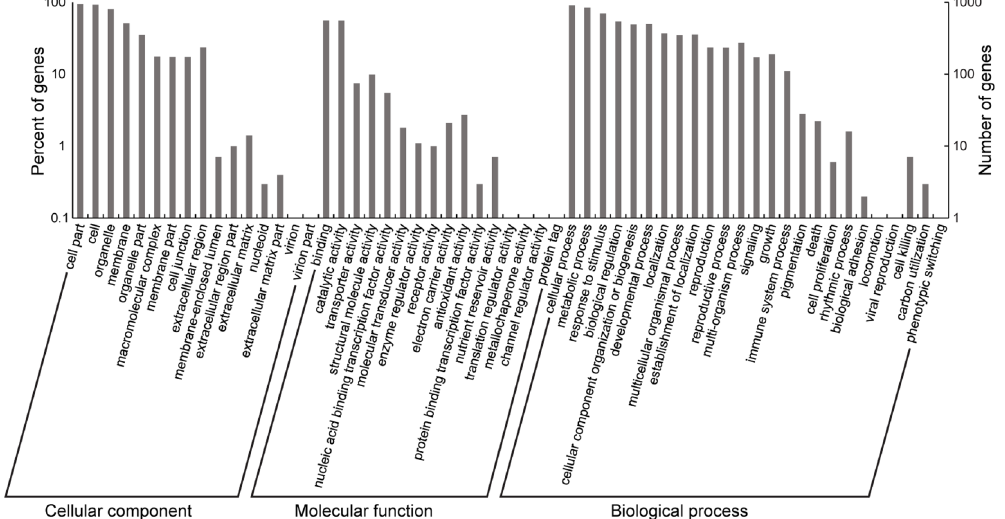
Fig 4. Classification of the genes in P . americana in response to cadmium via Gene Ontology (GO)